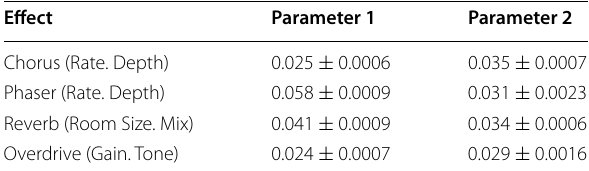
Table 9 95% gives 95 % confidence intervals of the mean absolute error of the parameter extraction of the convolutional neural network for the chorus, phaser, reverb, and overdrive effect using mel-frequency cepstral coefficients as